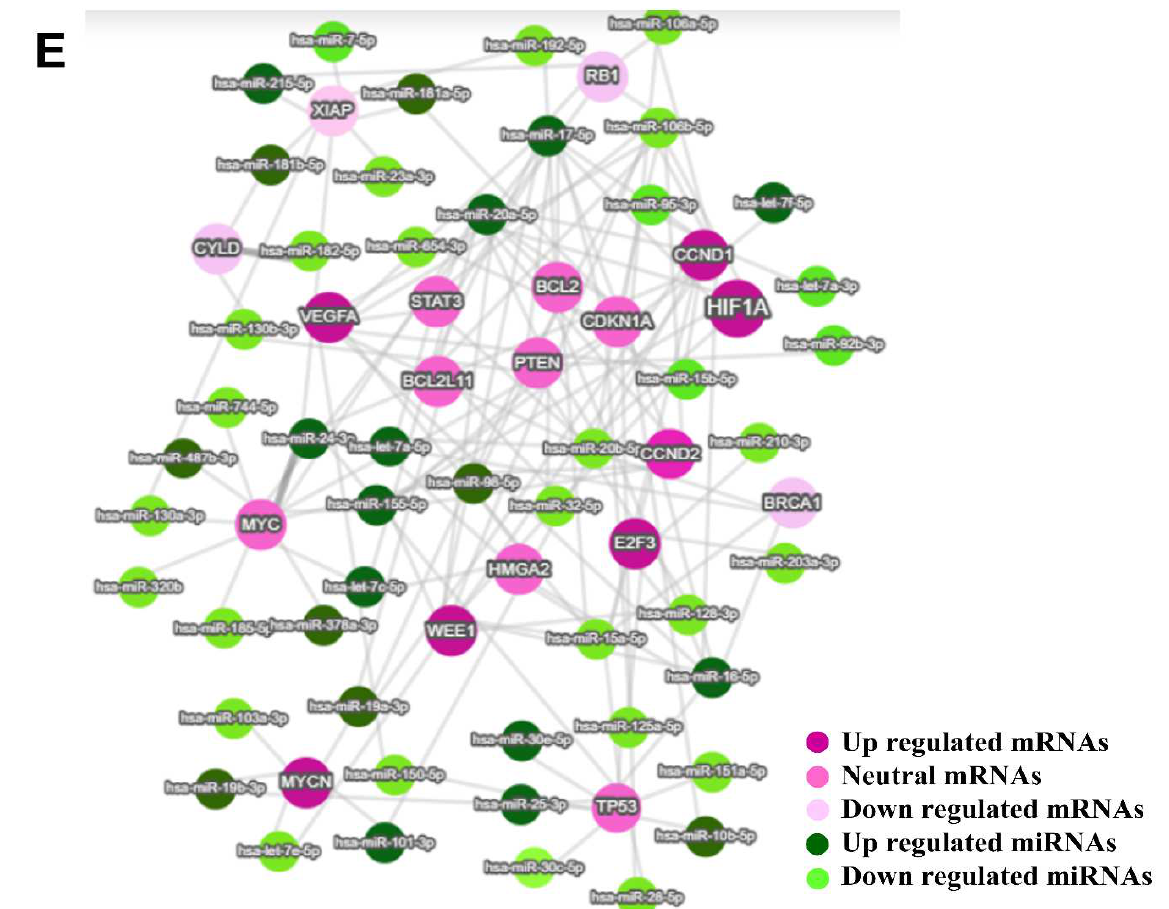
Figure 4. Functional enrichment analysis of differentially expressed miRNA-targets in Retinoblastoma (RB) serum small EVs. ( A – C ). Gene ontology (BP—Biological process, MF-Molecular function and CC—Cellular component) terms ( D ). KEGG terms. ( E ): The interaction network of differentially expressed (DE) miRNAs and their experimentally validated target genes (DE mRNAs) identified in retinoblastoma serum small EVs was generated by miRTargetLink 2.0 using the strong interaction and minimum 5 shared targets options.